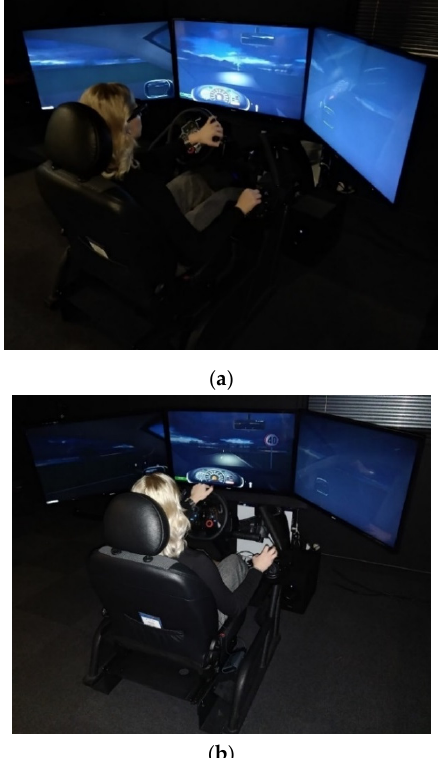
Figure 3. Representation of research implementation: ( a ) scenario without tra ffi c signalling; ( b ) scenario with “included” tra ffi c